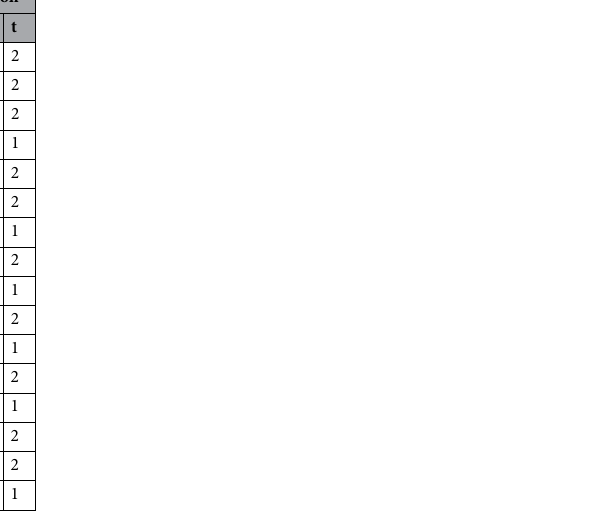
Table 2. Selection of EMCs and corresponding t-values for two new annual (EFR Ann) and monthly (EFR Mon) methods based on providing 70.5% of the annual flow of each of the rivers as the